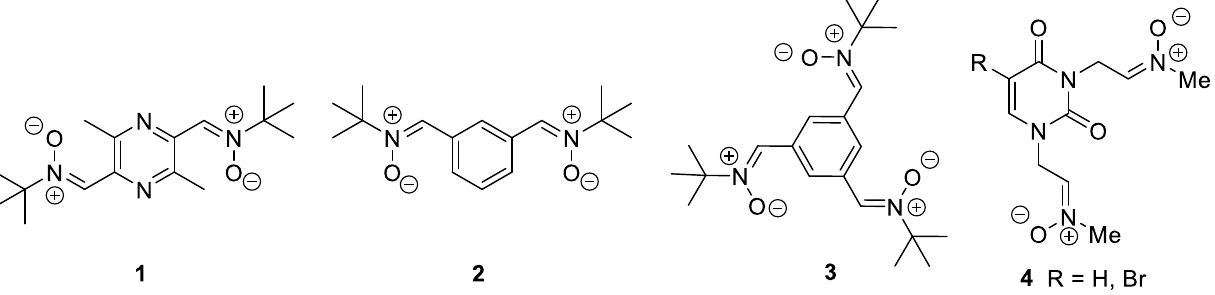
Figure 2. Examples of active bis- and tris-nitrones.